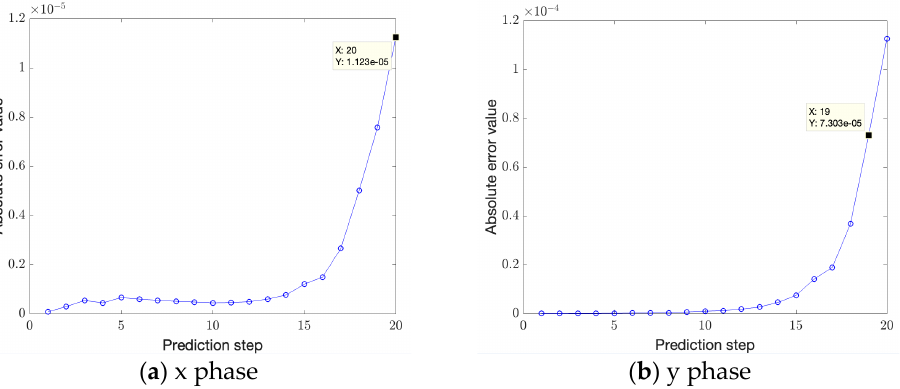
Figure 11. T hree-dimensional Lorenz error iterative convergence curve. The blue line represents the absolute error value curve, and the blue circle represents the absolute error value.